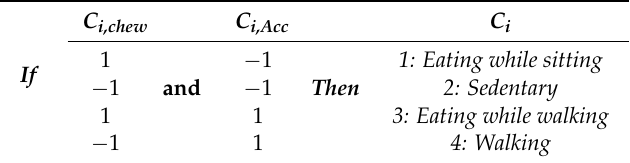
Table 2. Decision tree rules for determining the final class label from the two-stage classifier.